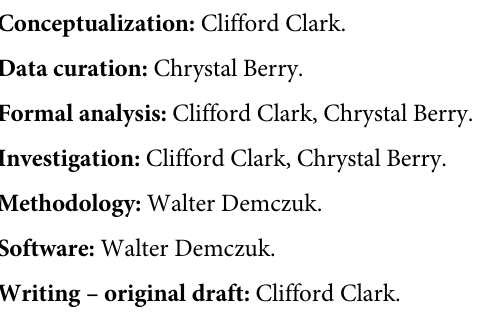
S1 Table. List of strains and accession numbers used in this analysis. (DOCX) S2 Table. Genetic context of Tlps: flanking genes/proteins and tRNAs. (DOCX) S3 Table. Invertible element size in Cj and Cc strains. S4 Table. Descriptive statistics for Cj and Cc Invertible Elements